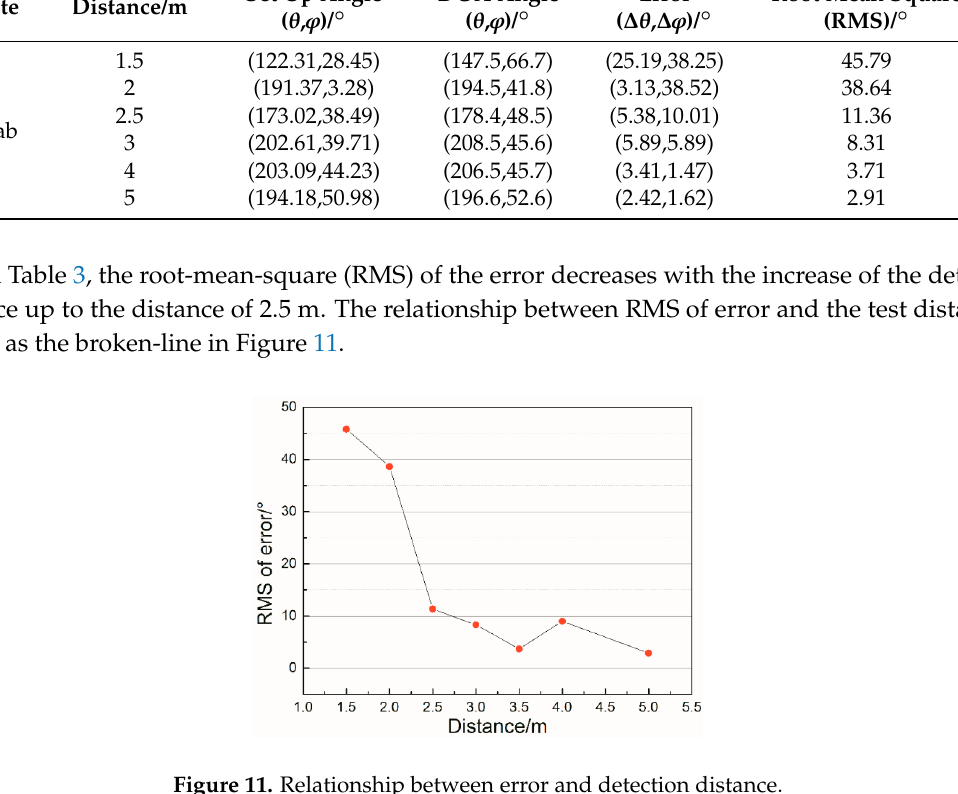
Table 3. Test results in lab.